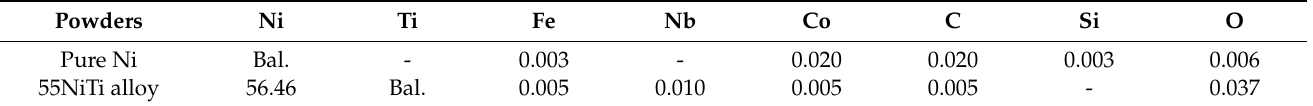
Table 1. Chemical composition of Ni and 55NiTi alloy powders (wt.%).